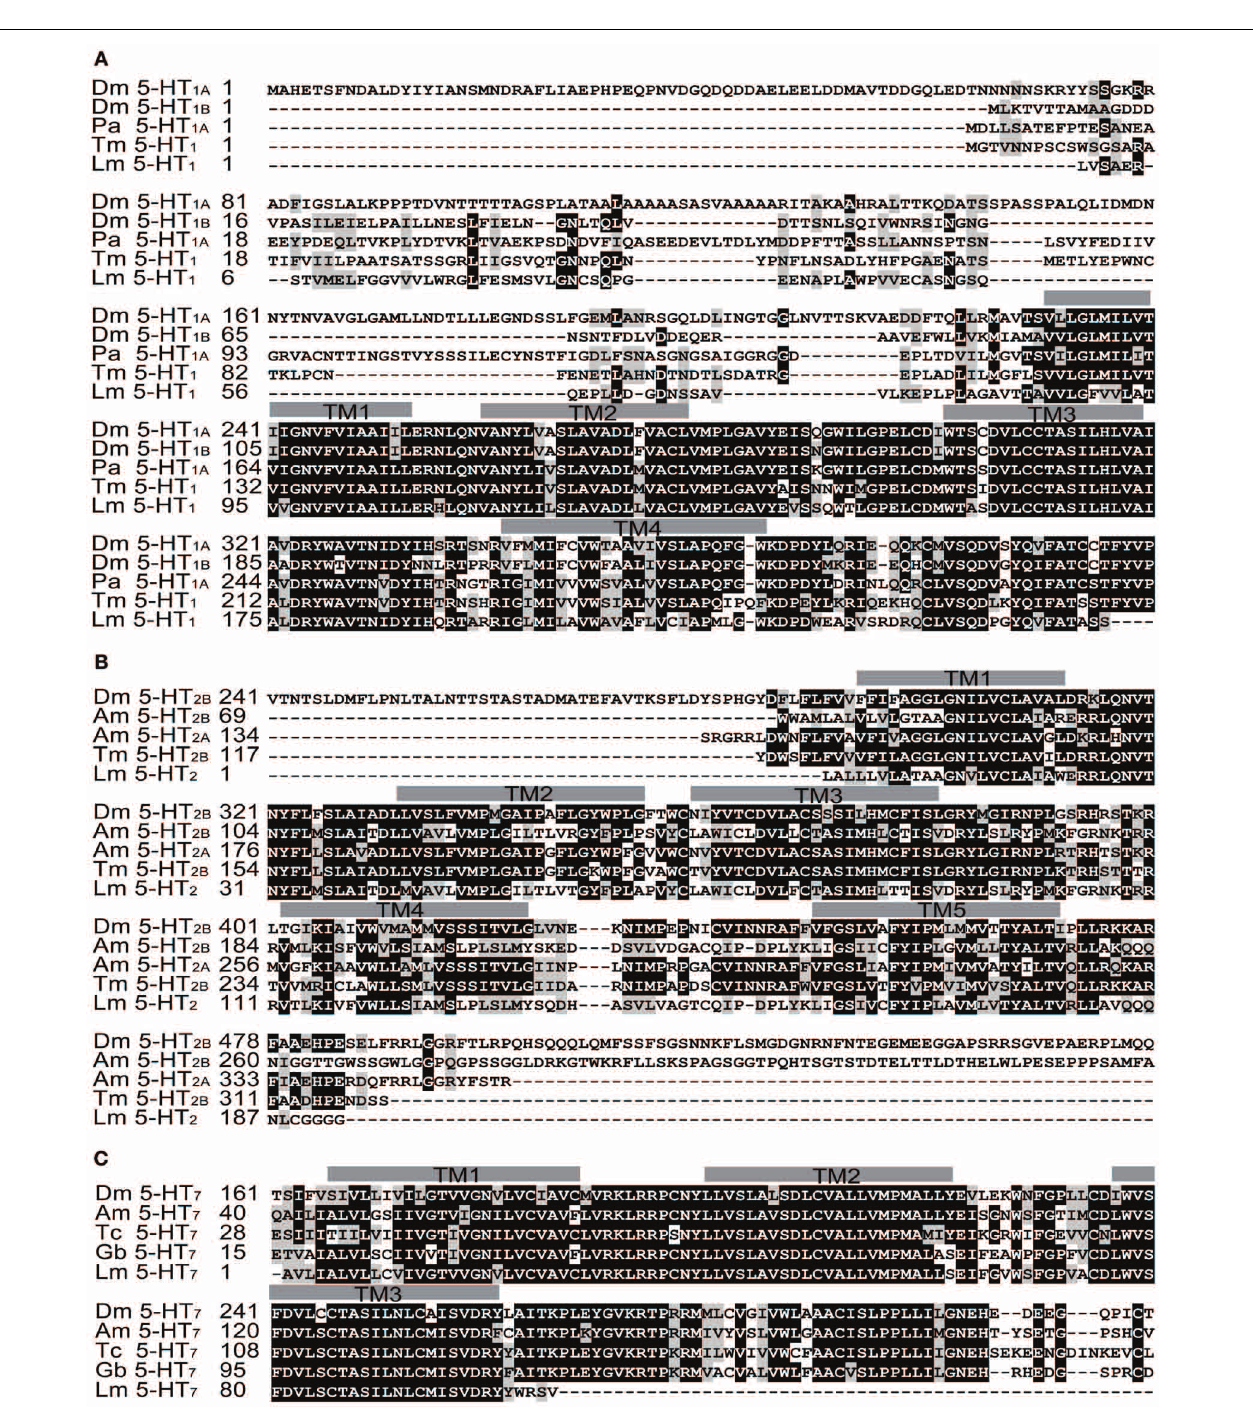
castaneum (Tc 5-HT 2B , NP_972327). (C) Sequence alignment of the Lm 5-HT 7 with orthologous receptors from Drosophila melanogaster (Dm 5-HT 7 , NP_524599), Apis mellifera (Am 5-HT 7 , CAJ28210), Tribolium castaneum (Tc 5-HT 7 , XP_966577), and Gryllus bimaculatus (Gb 5-HT 7 , BAJ83482). Identical residues of the aligned sequences are shown as white letters against black ones, whereas conservatively substituted residues are shaded. Putative transmembrane regions are indicated by gray bars. Dashes indicate gaps that were introduced to maximize